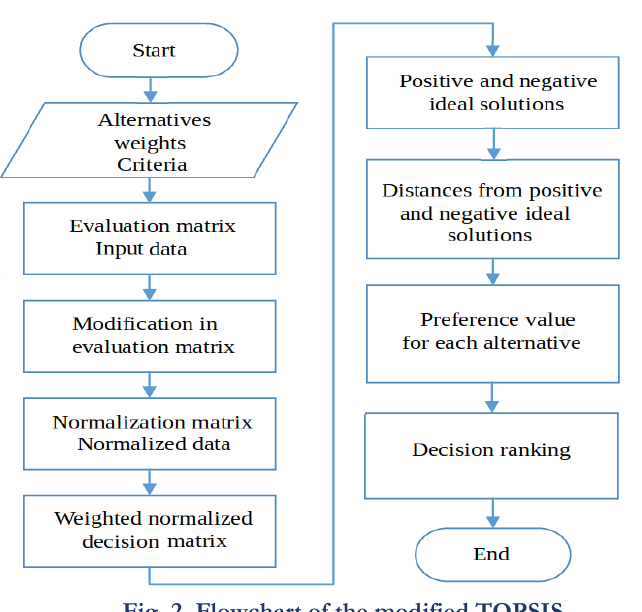
Fig. 2. Flowchart of the modified